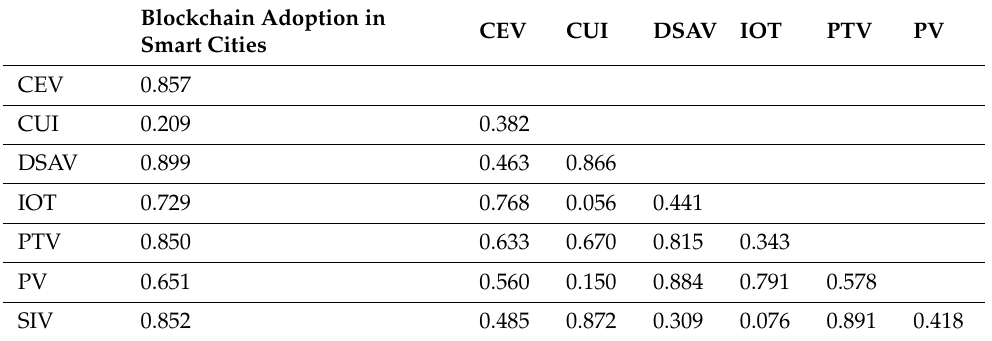
Table 4. Discriminant Validity of Reflective